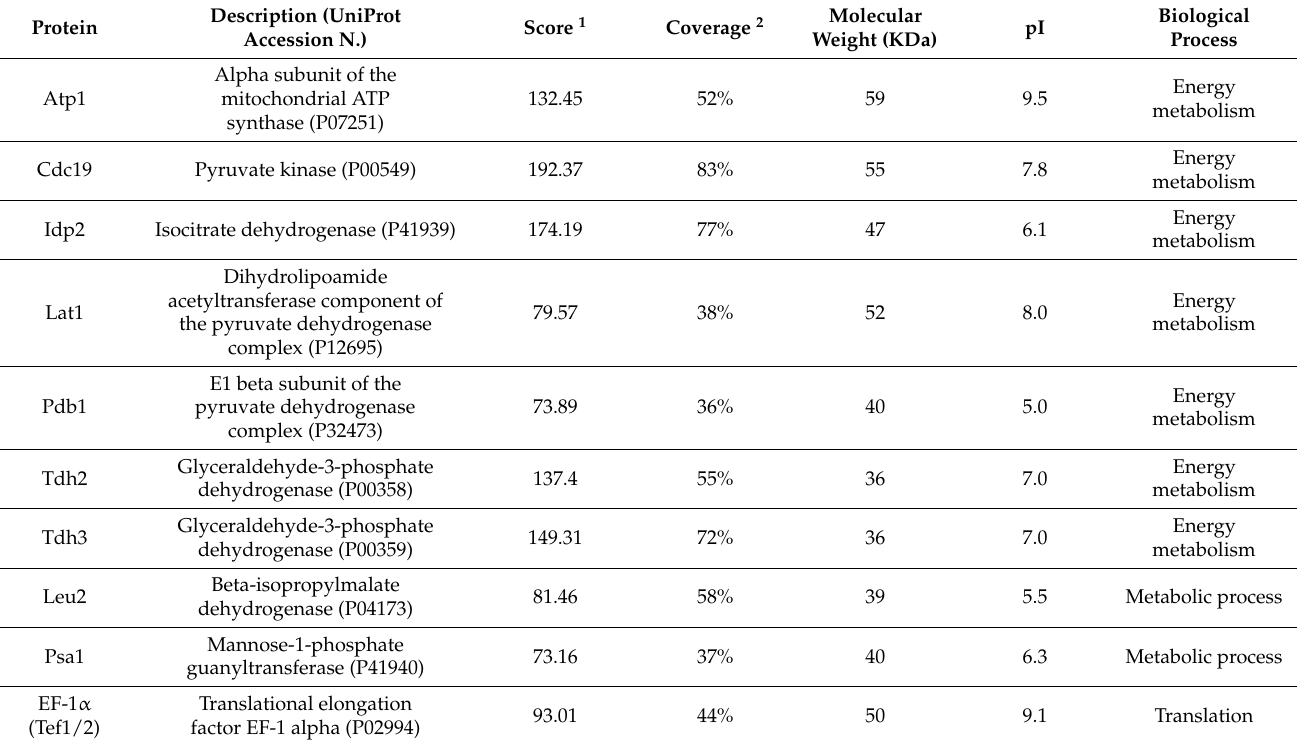
Table 2. Protein composition of the hard protein corona of CdS